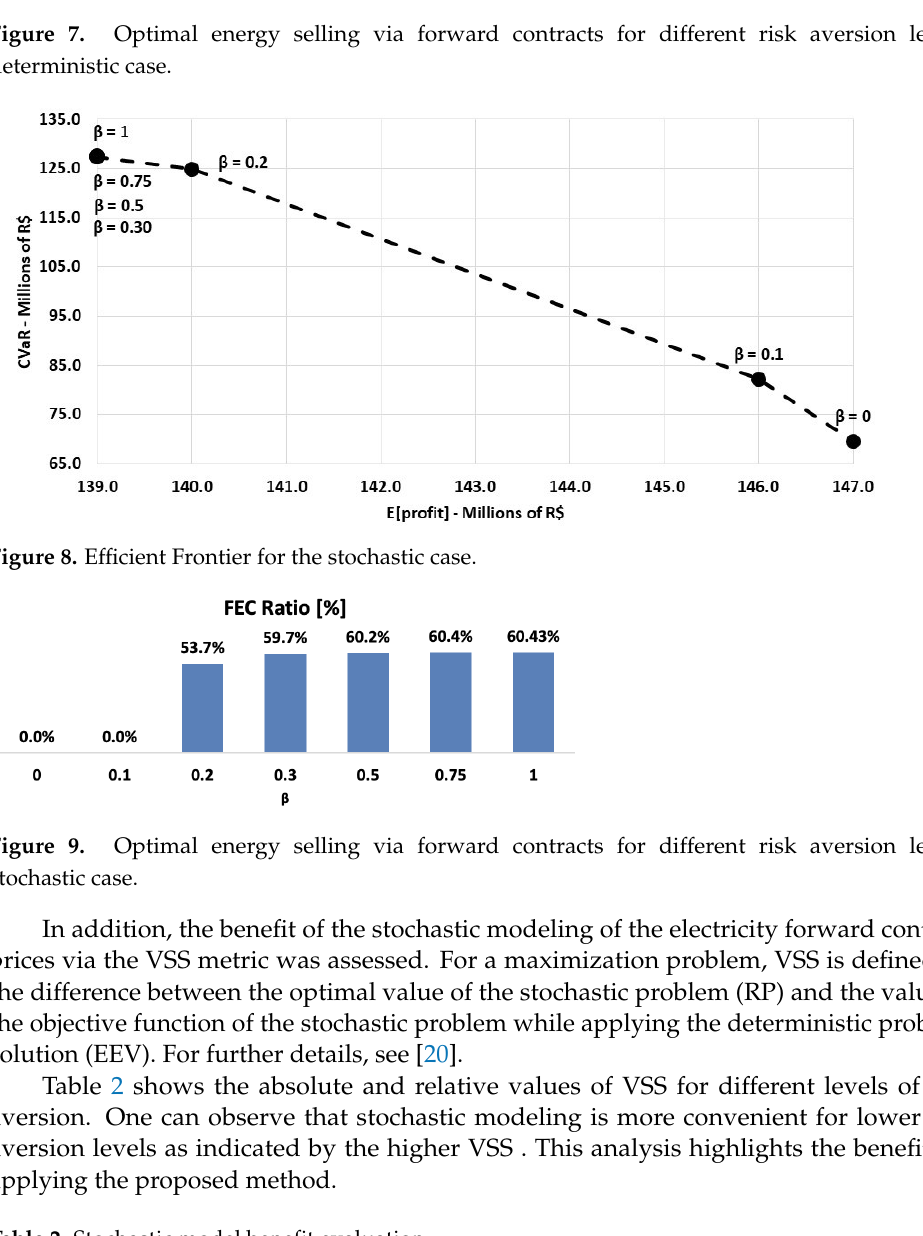
Table 2. Stochastic model benefit